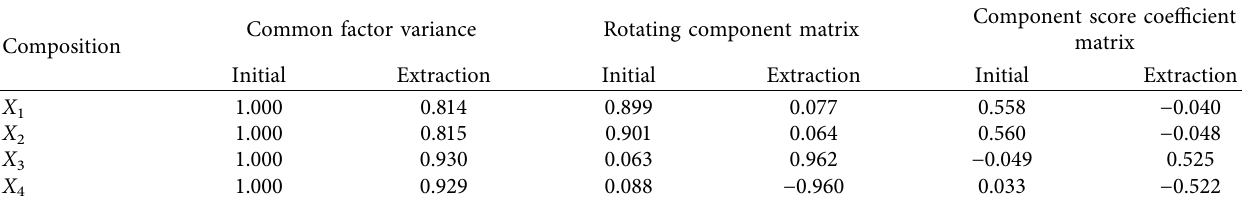
Table 4: Common factor variance, rotation component matrix, and score coefficient matrix.